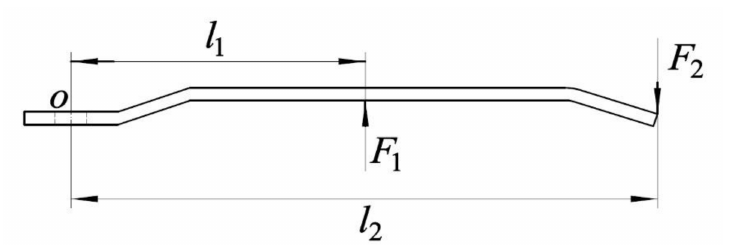
Figure 5. Force analysis of snapping